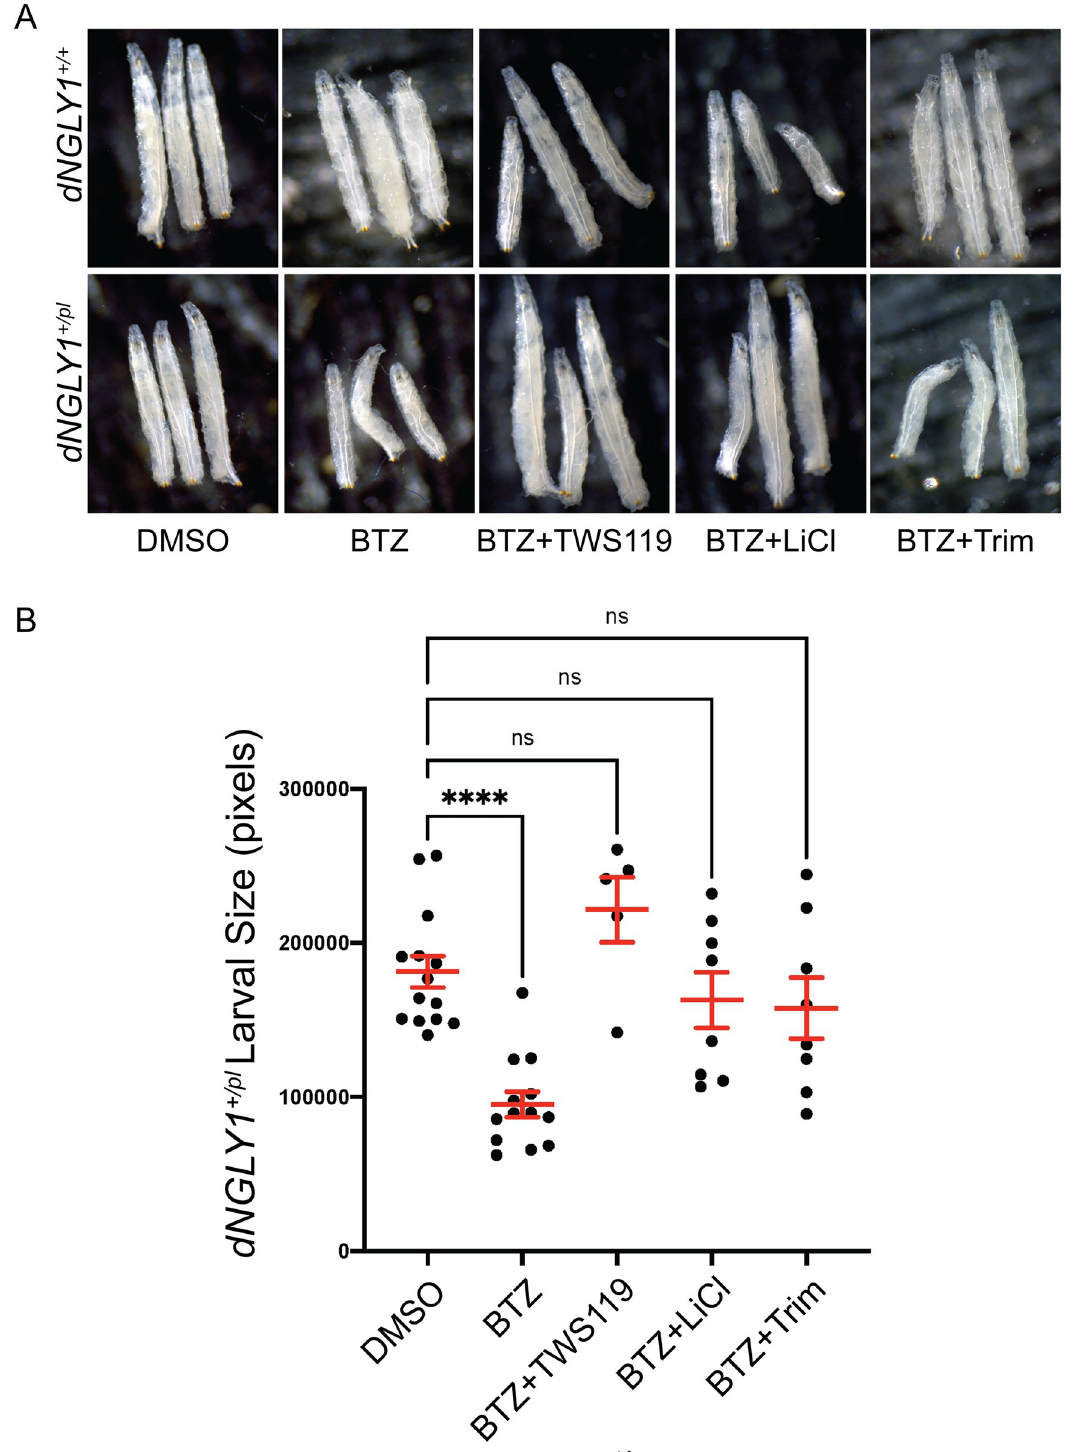
Fig 6. GSK3 inhibitors and trimipramine rescue size defects in dNGLY1 +/pl larvae upon proteasome inhibition. Pretreatment with TWS119, LiCl, or trimipramine rescue proteasome inhibition-induced size reduction in dNGLY1 +/pl larvae. A) Images of dNGLY1 +/+ and dNGLY1 +/pl treated with DMSO, bortezomib (BTZ) alone, or BTZ with drug. B) Quantification of dNGLY1 +/pl larval size. dNGLY1 +/pl were significantly smaller when treated with 5 μ M BTZ compared to DMSO. There were no significant differences in dNGLY1 +/pl larvae treated with DMSO compared to 5 μ M BTZ+1 μ M TWS119, 5 μ M BTZ+1 mM LiCl, or 5 μ M